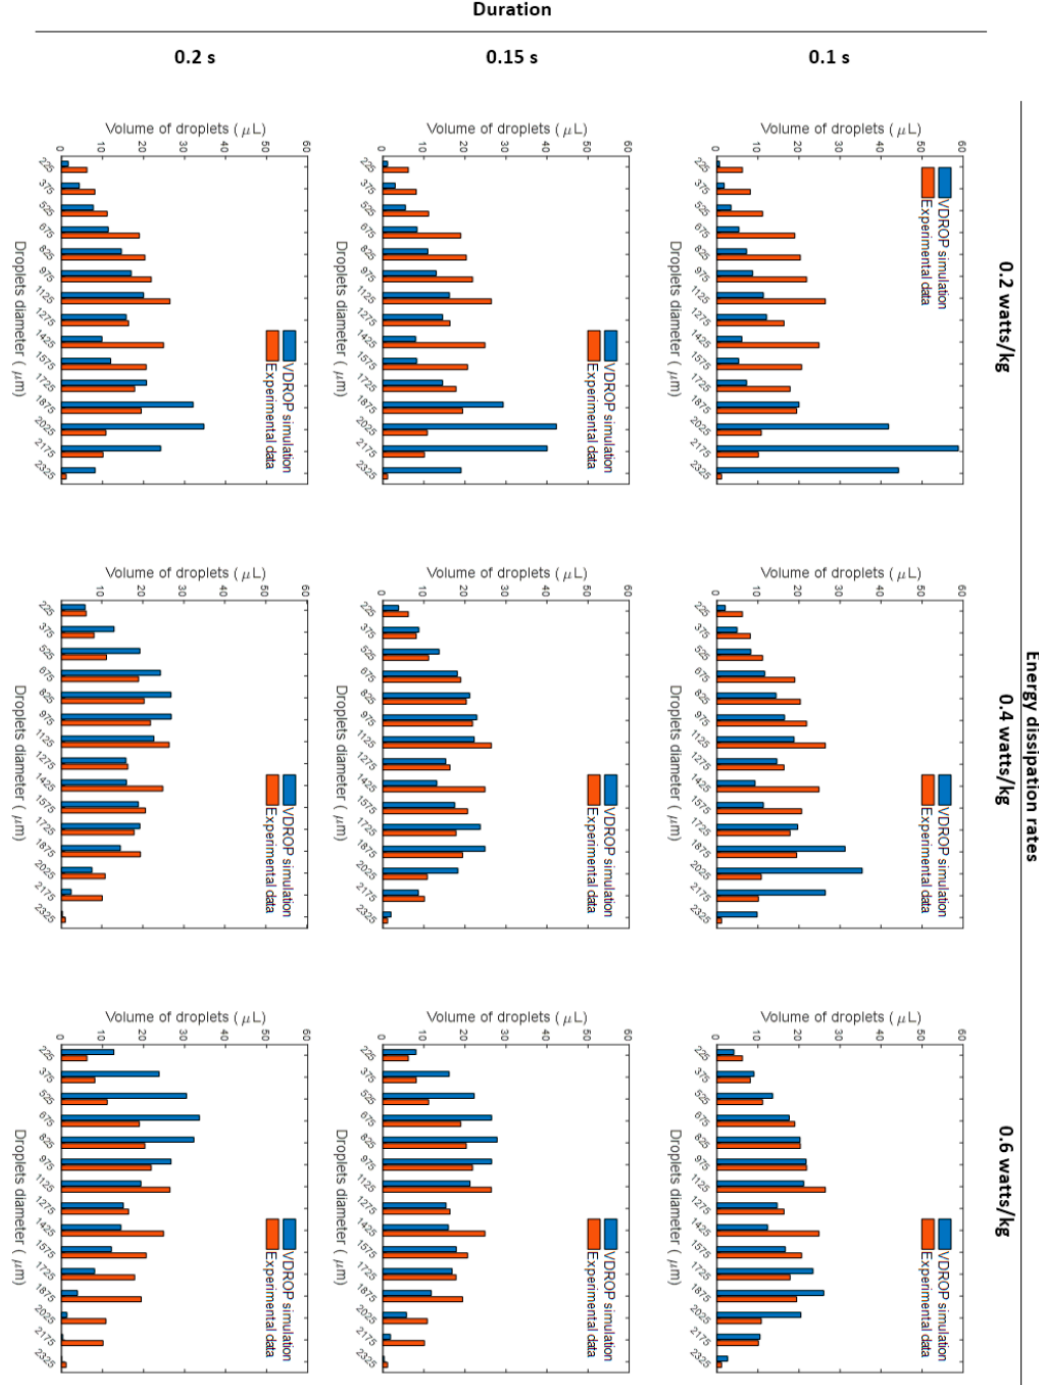
Figure 11. Volume-based DSD for various parameters of the VDROP model. The experimental DSD is also